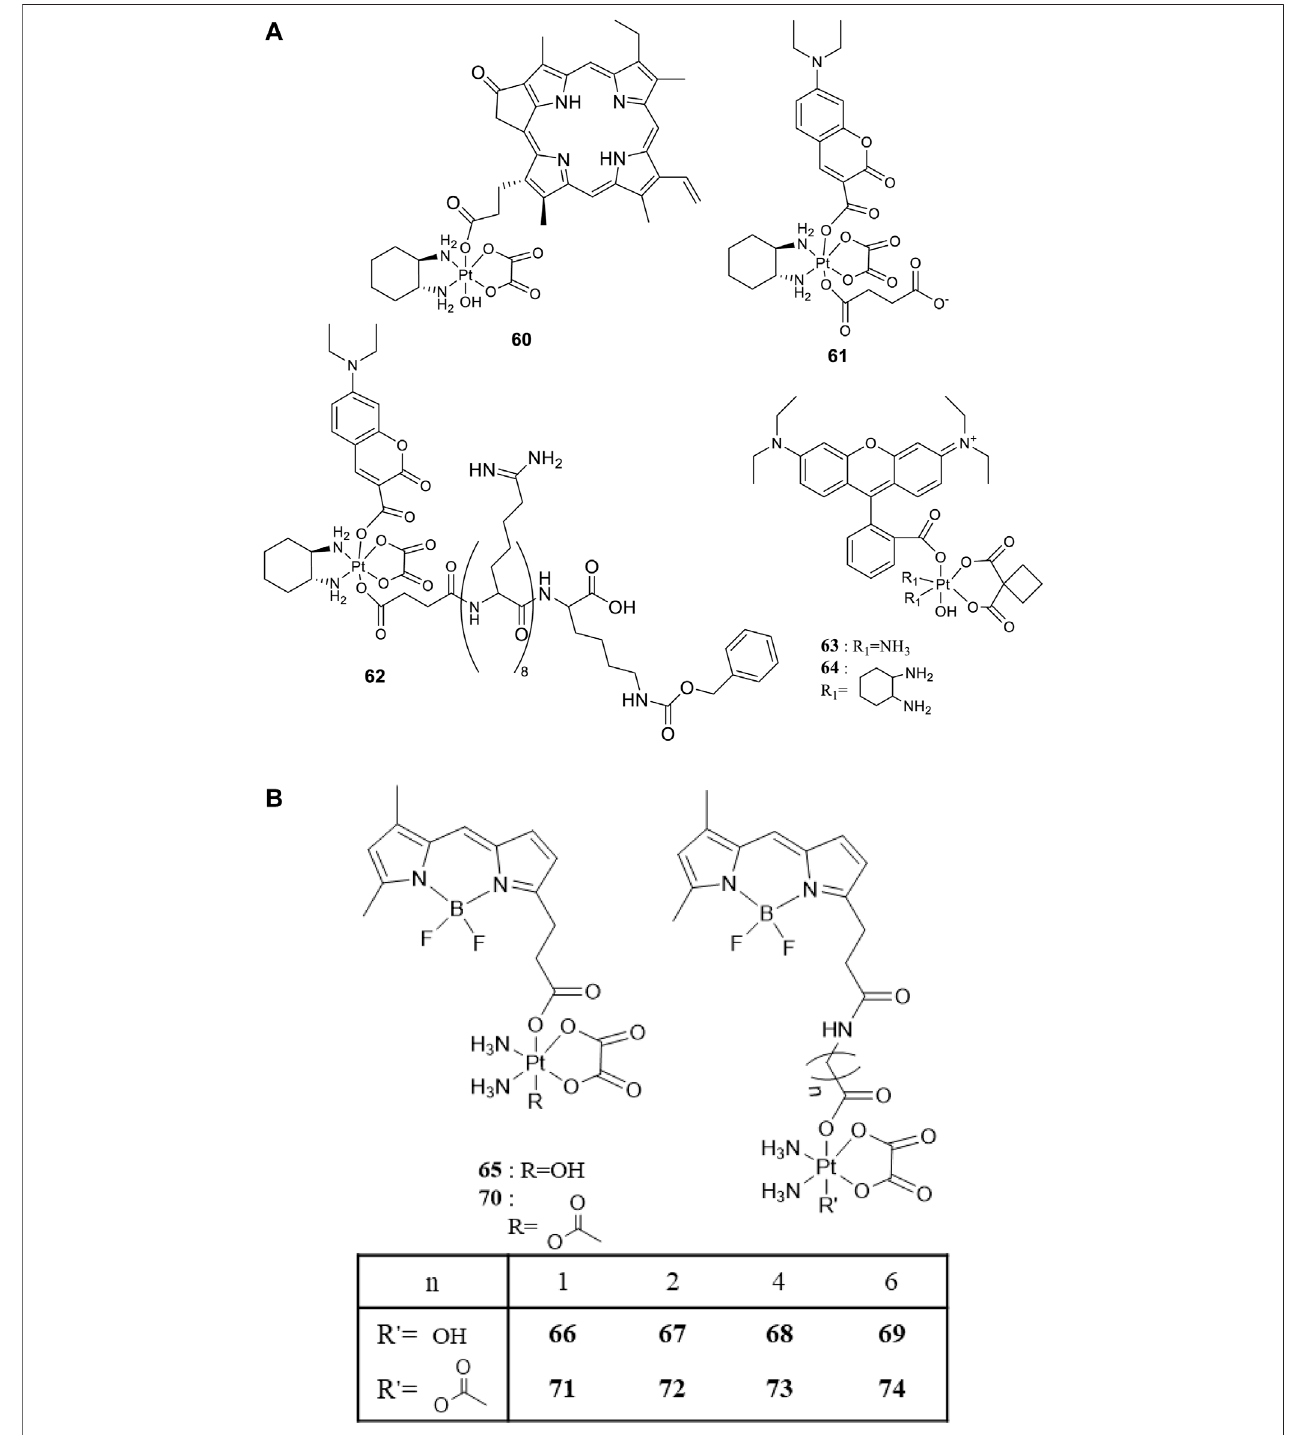
FIGURE 5 | (A) Chemical structures of complexes 60 – 64 [adapted from Wang et al. (2019); Deng et al. (2020); Deng et al. (2021)]. (B) Chemical structures of BODIPY-conjugated Pt(IV) prodrugs [adapted from Yao et al. (2020); Yao et al. (2021)].